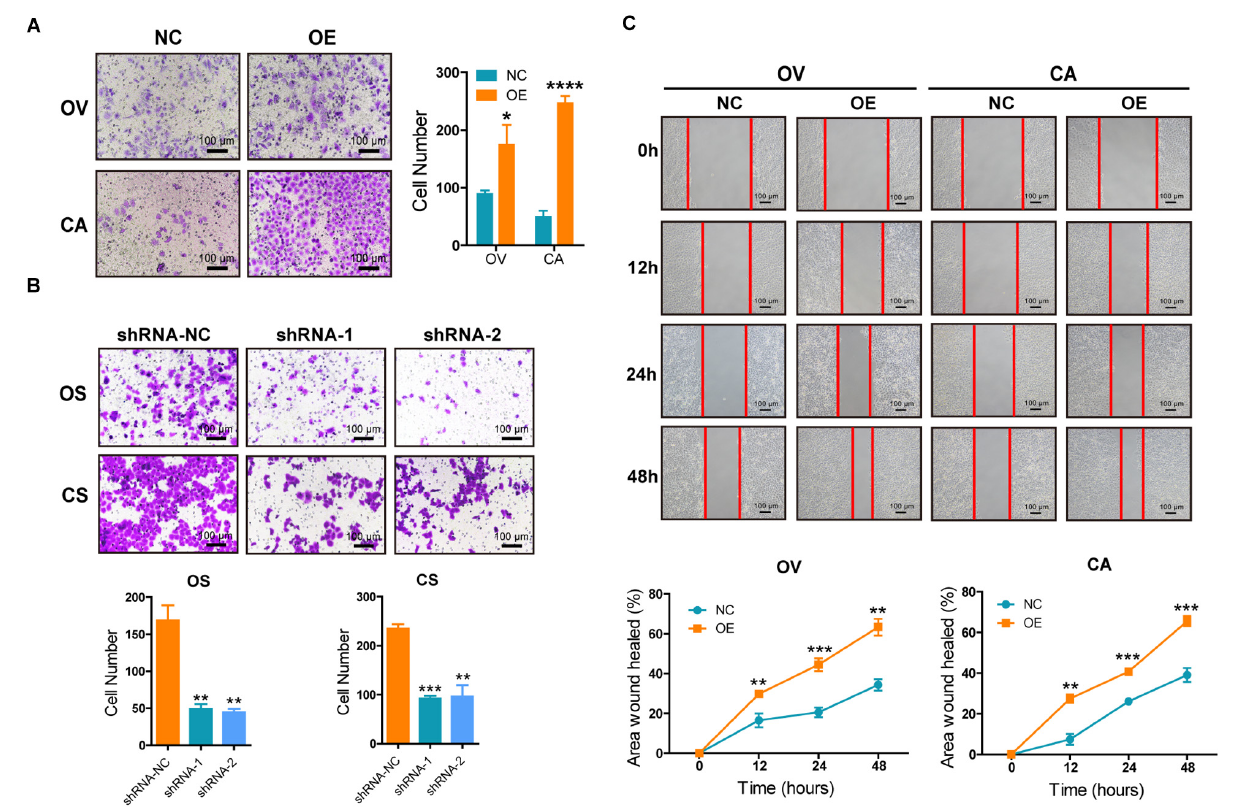
FIGURE 4 | SNORA72 promotes the migration abilities of ovarian cancer cells. (A) Migration abilities of OVCAR-3 (OV) and CAOV-3 (CA) cells transfected with the SNORA72 transfected (OE) or control (NC) plasmids by the Transwell assay. (B) Migration abilities of OVCAR-3 spheroid (OS) and CAOV-3 spheroid (CS) cells transfected with the shRNA-1, shRNA-2, or shRNA-NC plasmids by the Transwell assay. (C) Migration abilities of OV and CA cells transfected with the SNORA72 OE or NC plasmids by the wound-healing assay. * P < 0.05, ** P < 0.01, *** P < 0.001, and **** P < 0.0001.